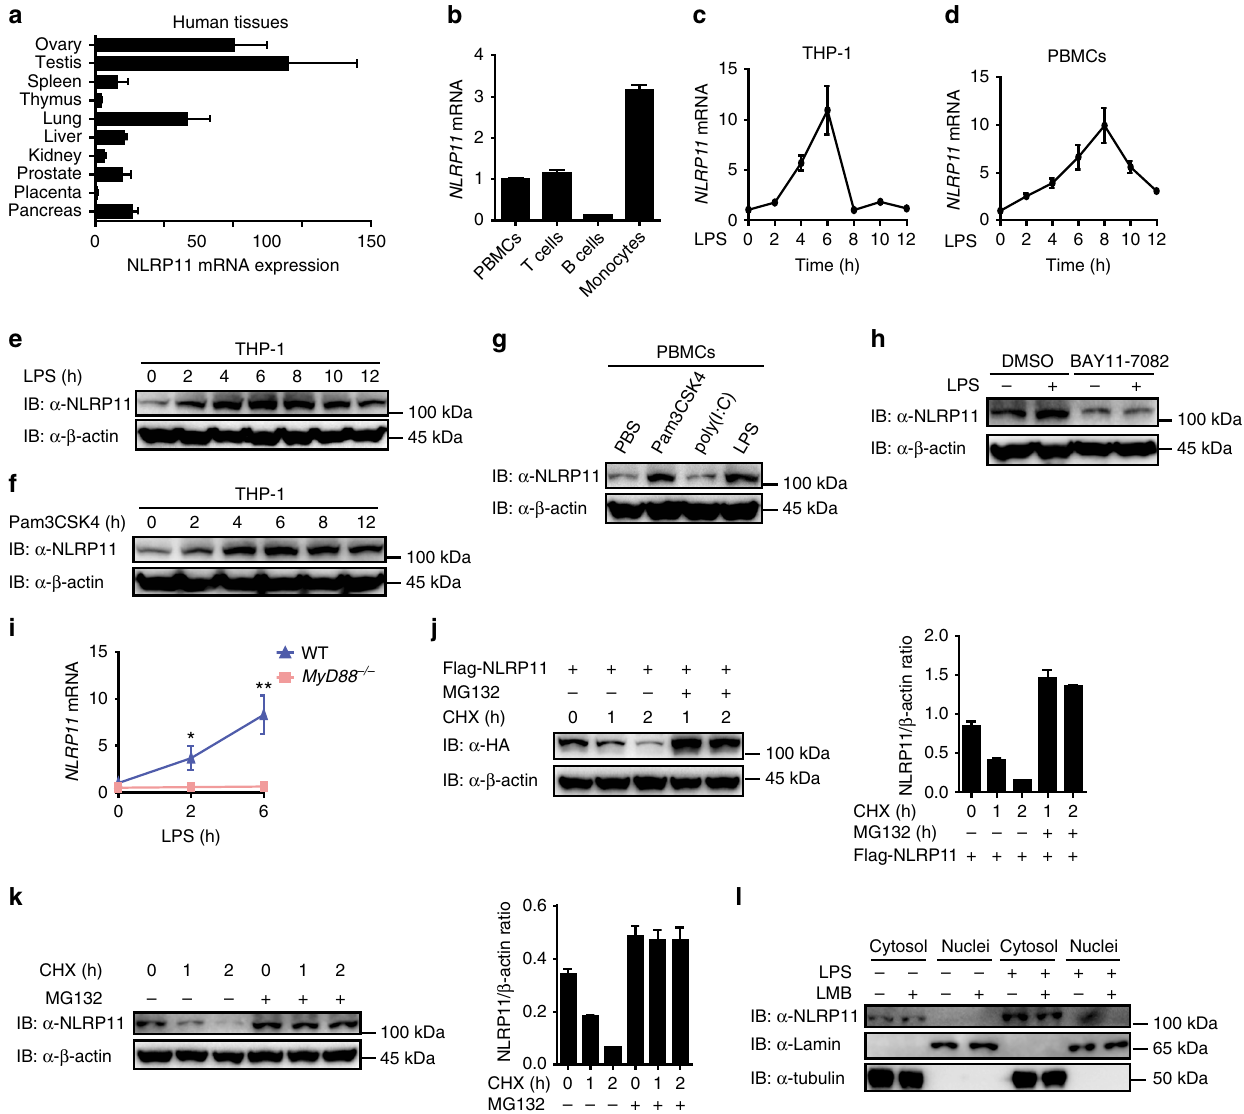
Fig. 1 Expression, protein stability and intracellular localization of NLRP11. a NLRP11 mRNA in different human tissues was analyzed by real-time PCR. b Real- time PCR analysis of NLRP11 expression in PBMCs, T cells, B cells, and monocytes. c , d THP-1 cells (a human monocytic leukemia cell line) c and PBMCs d were stimulated with LPS (100 ng/ml, a TLR4 ligand) at the indicated time points, then the transcription of NLRP11 was anyalyzed by real-time PCR. e , f Immunoblot analysis of NLRP11 expression in THP-1 cells treated with LPS (100 ng/ml) e or Pam3CSK4 (100 ng/ml, a TLR2 ligand) f for the indicated periods. g PBMCs were exposed to Pam3CSK4 (100 ng/ml), poly(I:C) (10 μ g/ml, a TLR3 ligand), LPS, or PBS for 8 h, and the cell lysates were immunoblotted with an anti-NLRP11 or β -actin antibody. h Immunoblot analysis of NLRP11 expression in THP-1 cells pretreated with BAY11-7082 (10 μ M, an inhibitor of I κ B α ) for 1 h, then stimulated with LPS for 6 h. i Wild type (WT) and MyD88 − / − THP-1 cells were stimulated with LPS and used for measuring its induction by real-time PCR. j 293T cells transfected with FLAG-tagged NLRP11 were either untreated or pretreated with MG132 for 6 h, then the cells were incubated with cycloheximide (CHX; protein synthesis inhibitor) and were immunoblotted with the indicated antibodies. k THP-1 cells were untreated or pretreated with MG132 for 6 h, then incubated with CHX for the indicated periods and were immunoblotted with indicated antibodies. l The THP-1 cells were stimulated or unstimulated with LPS for 8 h, and cytoplasmic and nuclear extracts of THP-1 cells were treated or untreated with 50 nM LMB for 4 h were analyzed by immunoblot with antibodies to NLRP11, tubulin (cytoplasmic fraction), and lamin (nuclear fraction). * P < 0.05, ** P < 0.01 using Student ’ s t -test. Data a – d and i are presented as mean ± SEM of combined from three independent experiments. Experiments e – h , j – l are representatives of three independent experiments with similar results. Data in j and k are presented as means ± SEM of combined from three independent